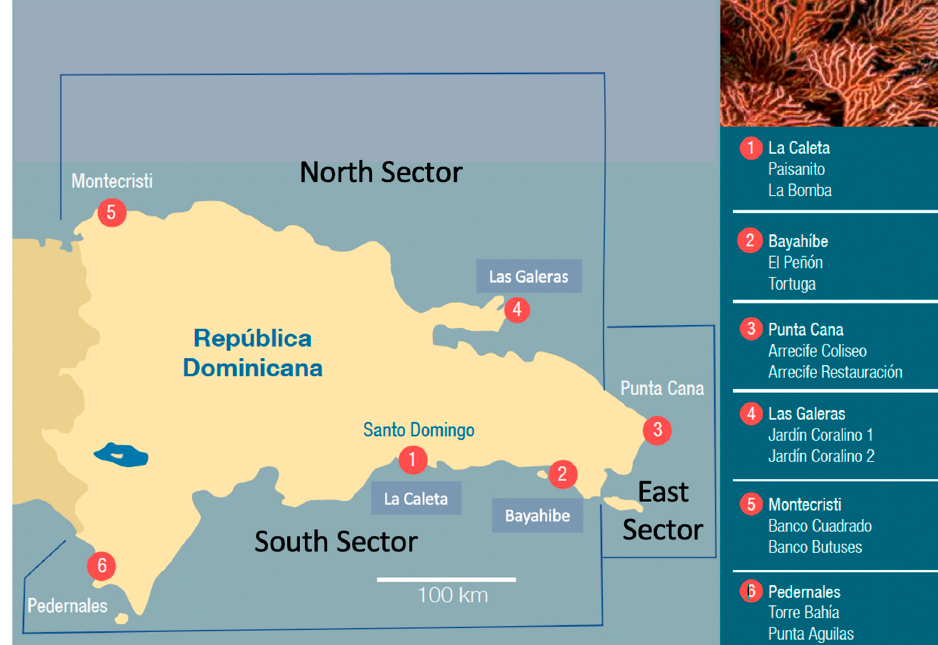
Figure 1. Six monitored regions (numbered in the figure and panel to the right). Each region contained two monitoring sites (listed in panel to the right). Regions were further subdivided into north, east, and south